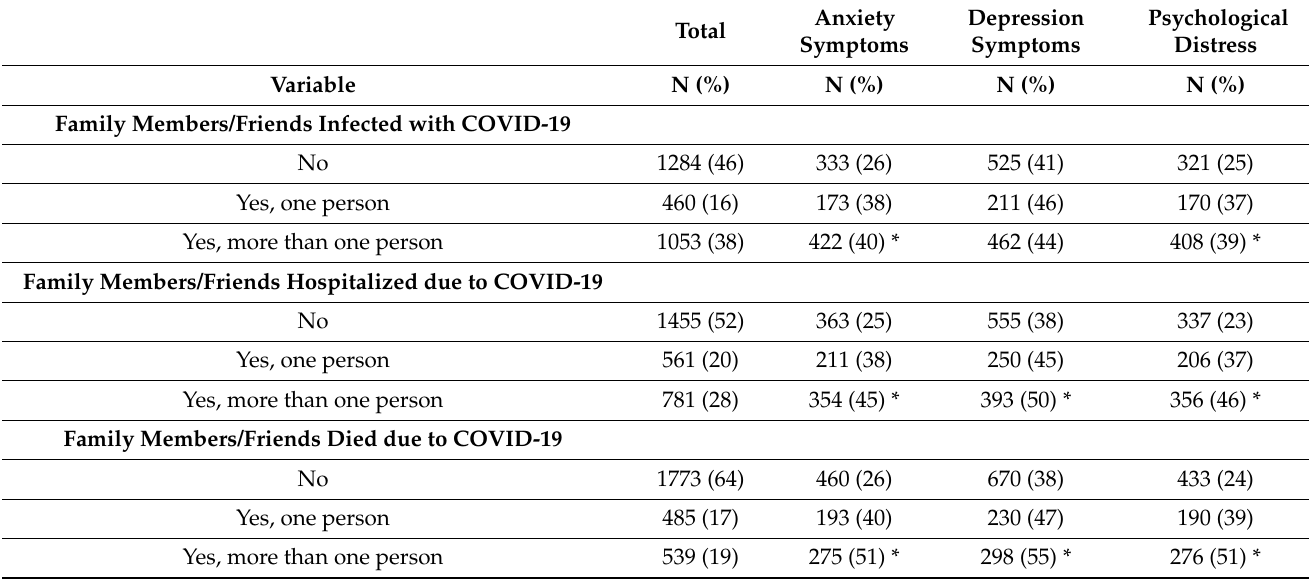
Table 2. COVID-19 Infection Among Family/Friends Stratified by Anxiety and Depression Symptoms.